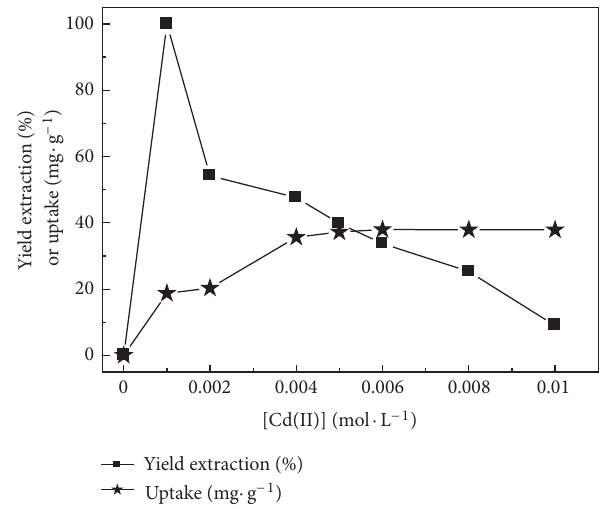
F 5: Effect of the initial concentration of Cd(II) on the uptake and the extraction yield. m = 0.030g, V = 5mL, equilibrium time = 180min, and initial pH =